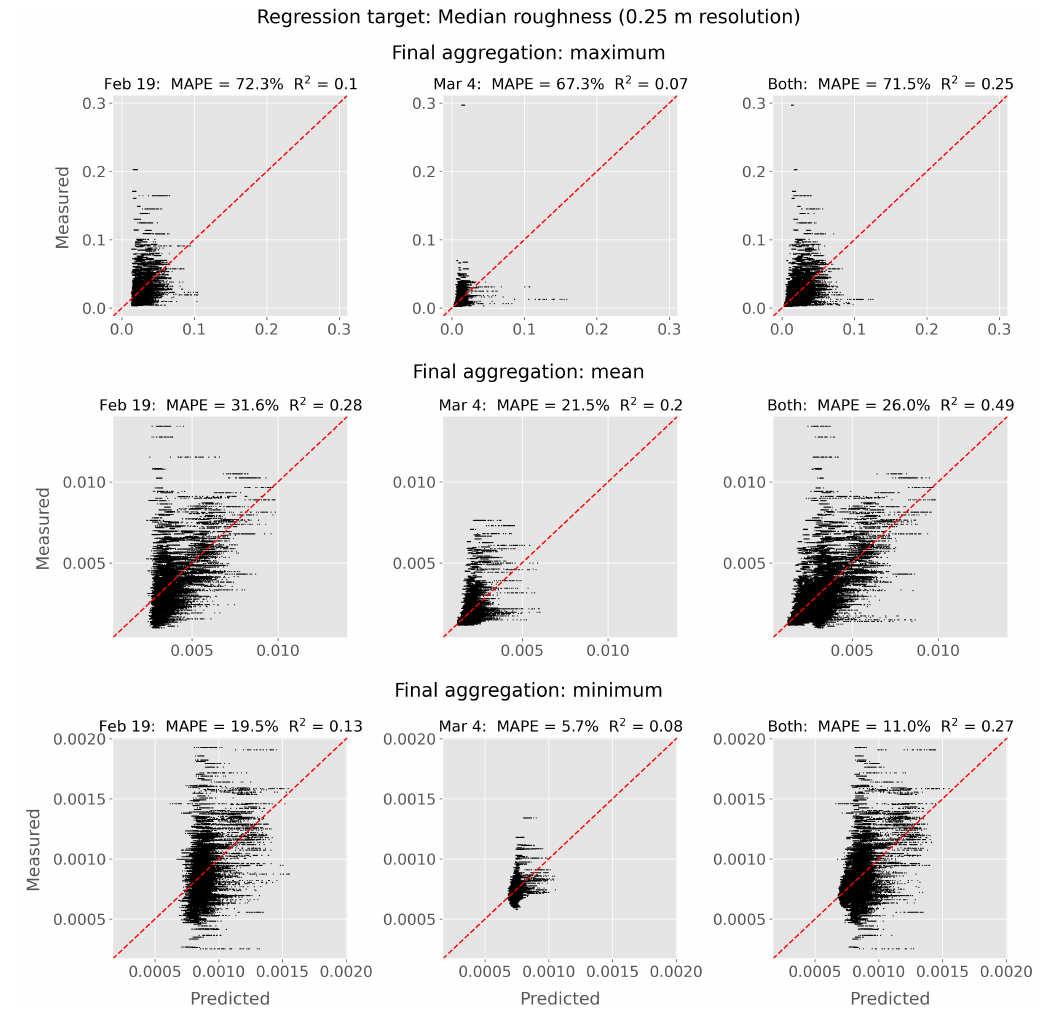
Figure 9. RF regression results for median surface roughness calculated at a subgrid resolution of 0.25 m. RF models are trained with input data sets with samples from 19 February only ( left column ), 4 March only ( middle column ), and both survey dates combined ( right column ). The final operations applied to aggregate the subgrid roughness metrics at the 10 m Sentinel-1 scale are the maximum ( top row ), mean ( middle row ), and minimum ( bottom row ). Red dashed lines are 1-1 lines representing perfect regression accuracy. Note the different y-axis limits between the three